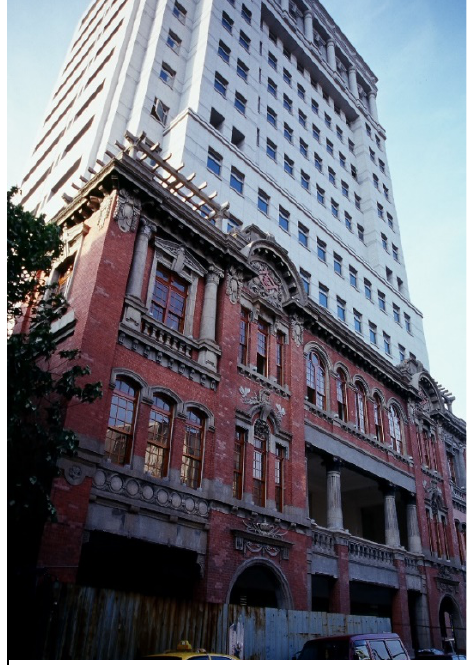
Figure 5: The estate owners can though the TDR to acquire the original development rights. It is a famous case, Ye’s house, at Dadaocheng area in Taipei